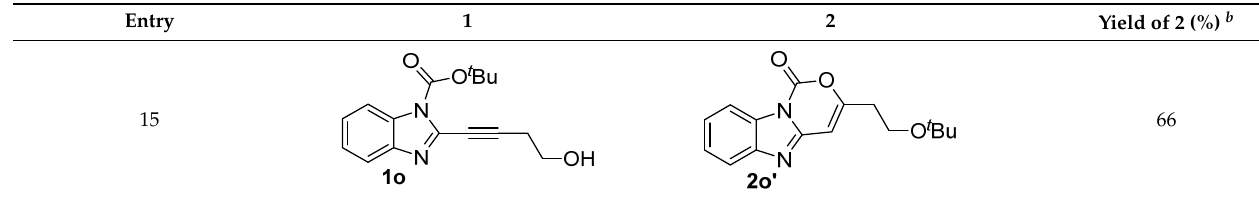
Figure 3. Molecular structure of 3-butyl-8-nitro-1 H -benzo[4,5]imidazo[1,2- c ][1,3]oxazin-1-one 2f . Color legend: carbon (light grey), hydrogen (white), oxygen (red), nitrogen (blue) (CCDC 2050711).